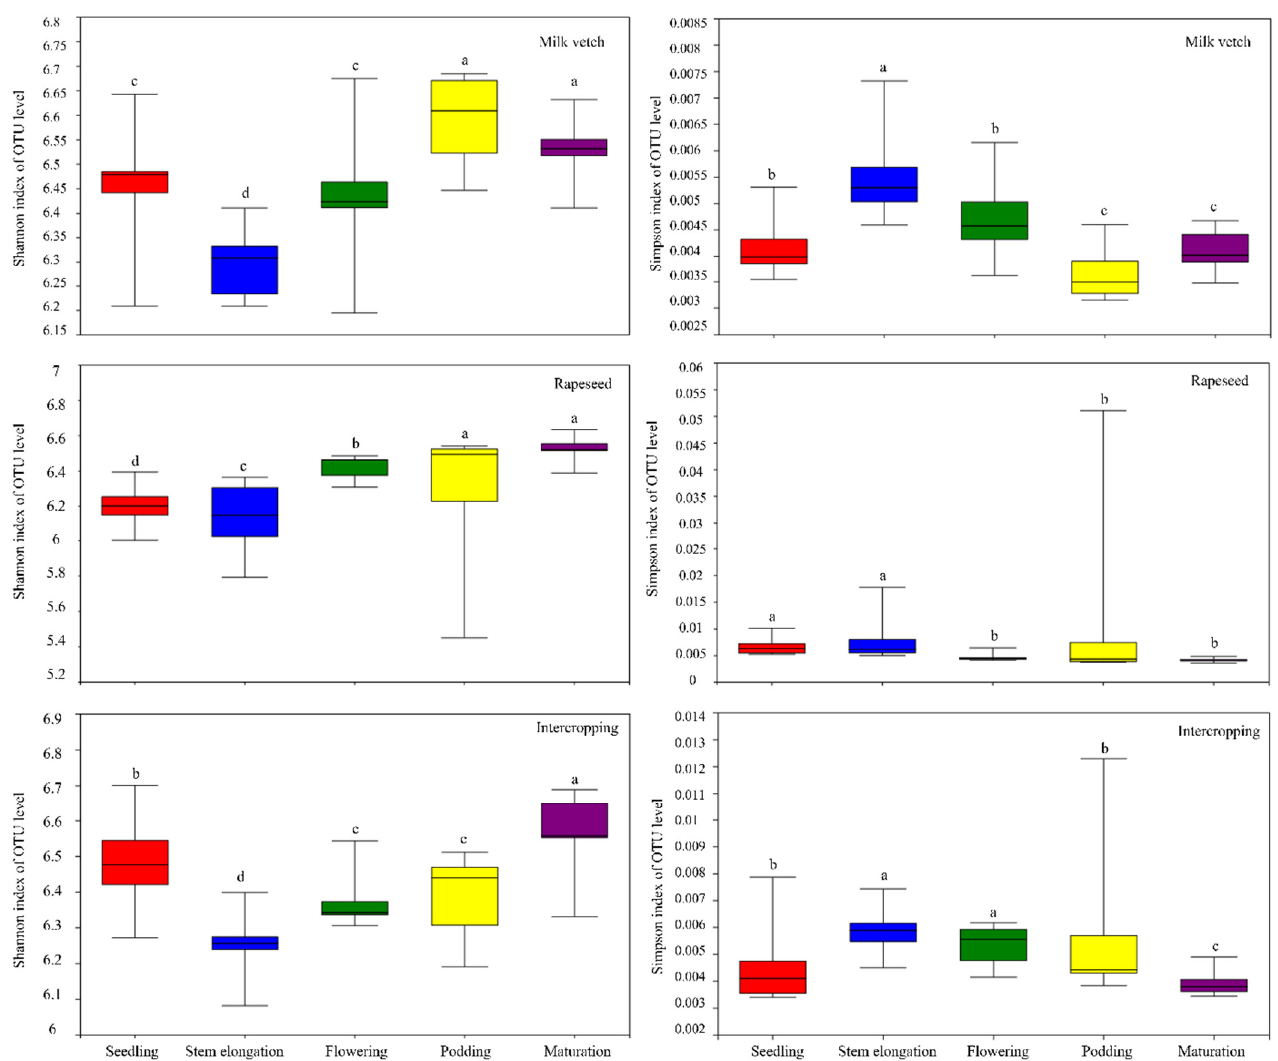
Figure 6. Shannon index and Simpson index of soil microorganisms. The top and bottom horizontal lines of the box in the figure are the maximum and minimum values of the sample data, respectively; the upper and lower limits of the box are the upper and lower quartiles of the data, respectively; the horizontal line in the box is the median. Letters represent the significant differences (p < 0.05, p<0.01) of Shannon and Simpson index between crop growth stages.